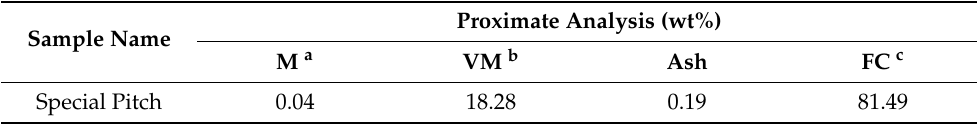
Table 1. Proximate analysis of raw